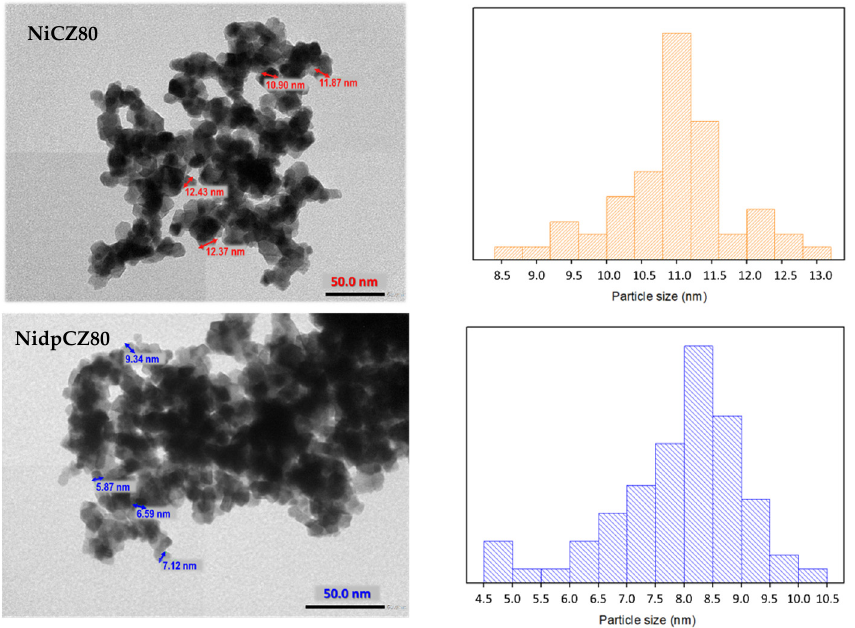
Figure 5. TEM images and particle size distribution of catalysts.